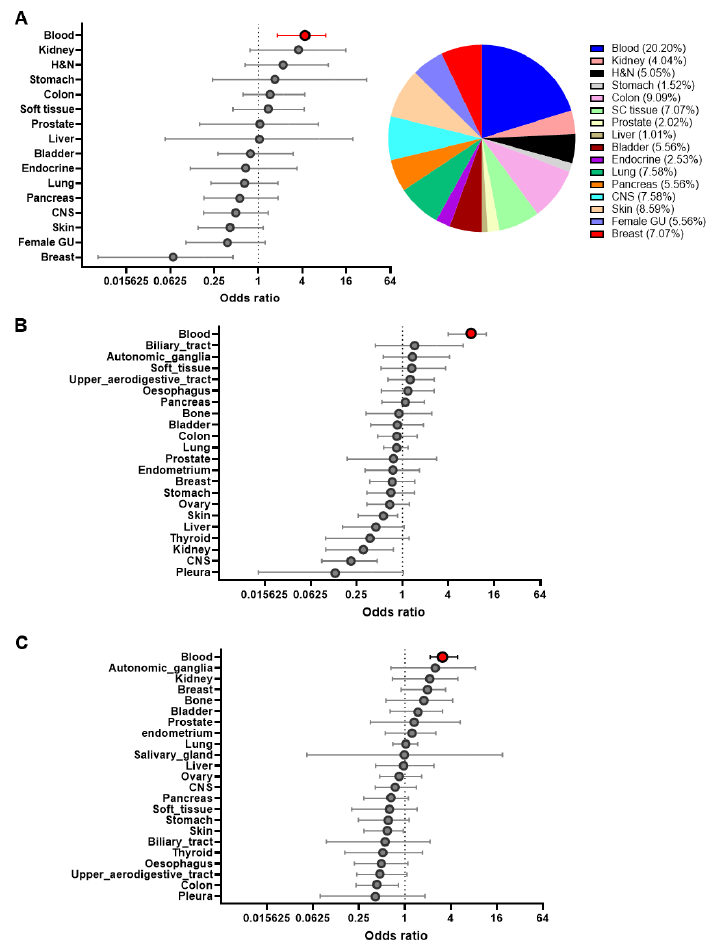
Figure 1. Comprehensive sensitivity profiles of NTX-301 and conventional HMAs in cancer cell lines (CCLs). ( A – C ) Plots of odds ratios (ORs) and 95% confidence intervals of CCL sensitivity to NTX-301 ( A , left), DAC ( B ), or AZA ( C ) grouped according to tissue type. Sensitive CCLs were defined as those with the lowest 50% AUC values of all the CCLs that were examined. The pie chart shows the proportion of each cancer type among the 199 CCLs ( A , right). AUC values for DAC and AZA are available from the Cancer Therapeutics Response Portal (CTRP). H&N, head and neck; CNS, central nervous system; GU, genitourinary system. Blood cancer is highlighted with red circles.